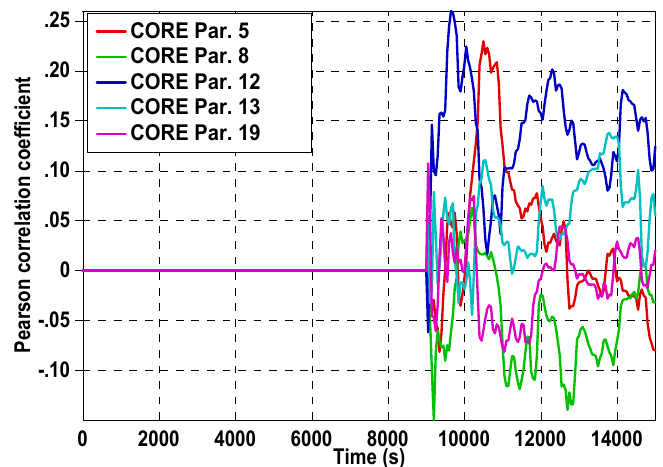
Figure 14. Pearson correlation coefficient between parameters related to core damage propagation and corium height in the lower head.